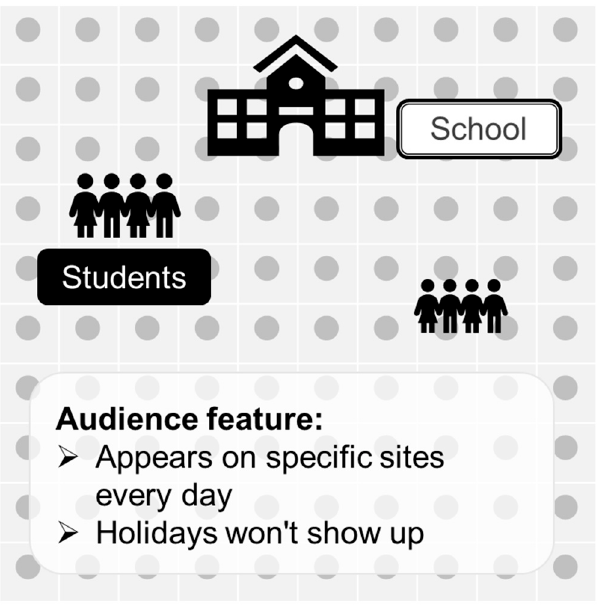
Figure 1. Audience feature in Case 1.